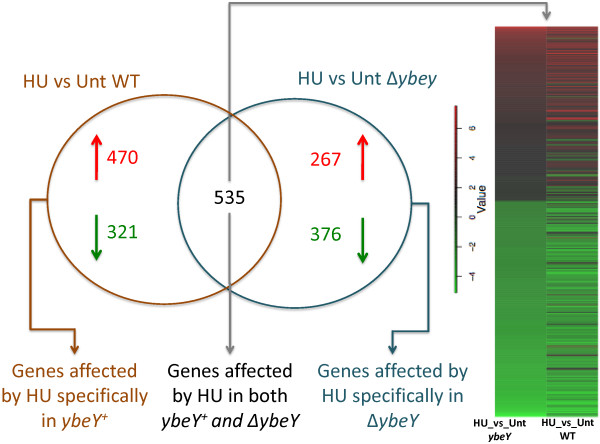
HU-mediated differential expression of genes in WT and ΔybeY genotypes. Venn diagram shows genes that are differentially regulated when WT and ΔybeY cells are exposed to HU-stress. Heat map shows the relative level of expression of genes that show a change in expression in both the genotypes upon HU treatment as compared to their respective untreated controls. Numbers in red represent genes upregulated whereas in green represent number of genes downregulated in respective conditions.